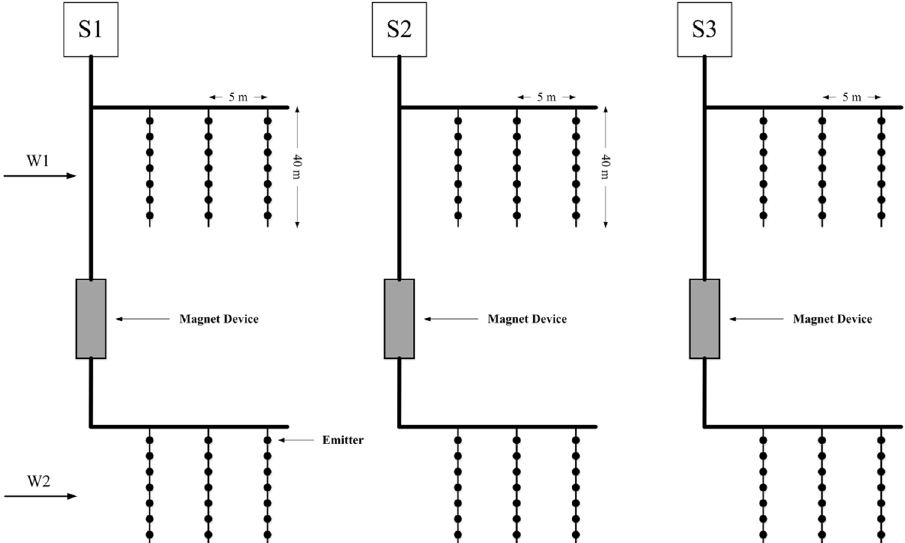
Fig. 1 The schematic of experimental system including the magnetic and non-magnetic